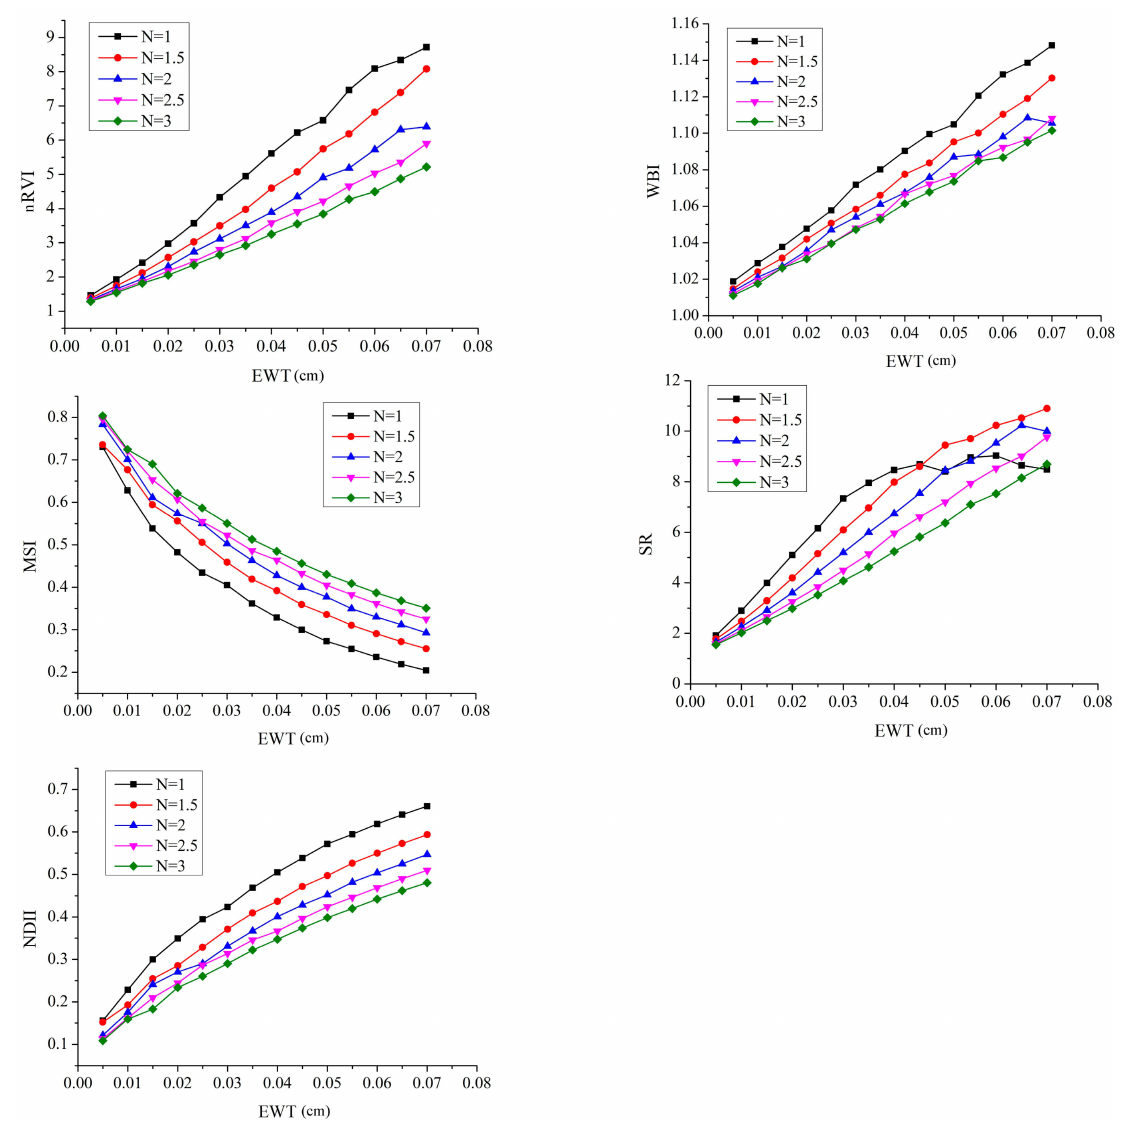
Figure 6. Robustness of nRVI, WBI, MSI, SR, and NDII to variations in N across various EWT